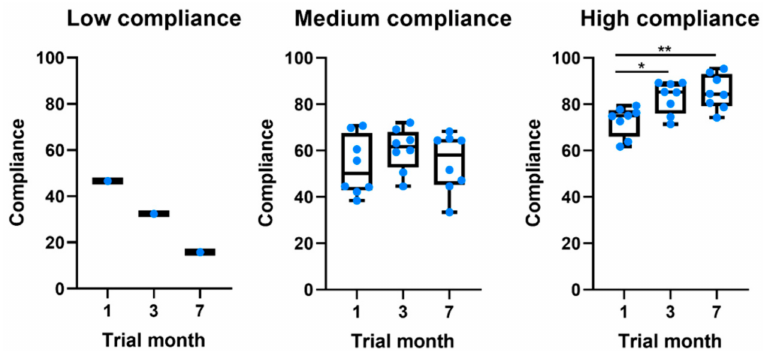
Figure 1. Boxplots comparing the evolution of compliance throughout the study for patients at different levels of global compliance. * p -value ≤ 0.05. ** p -value ≤